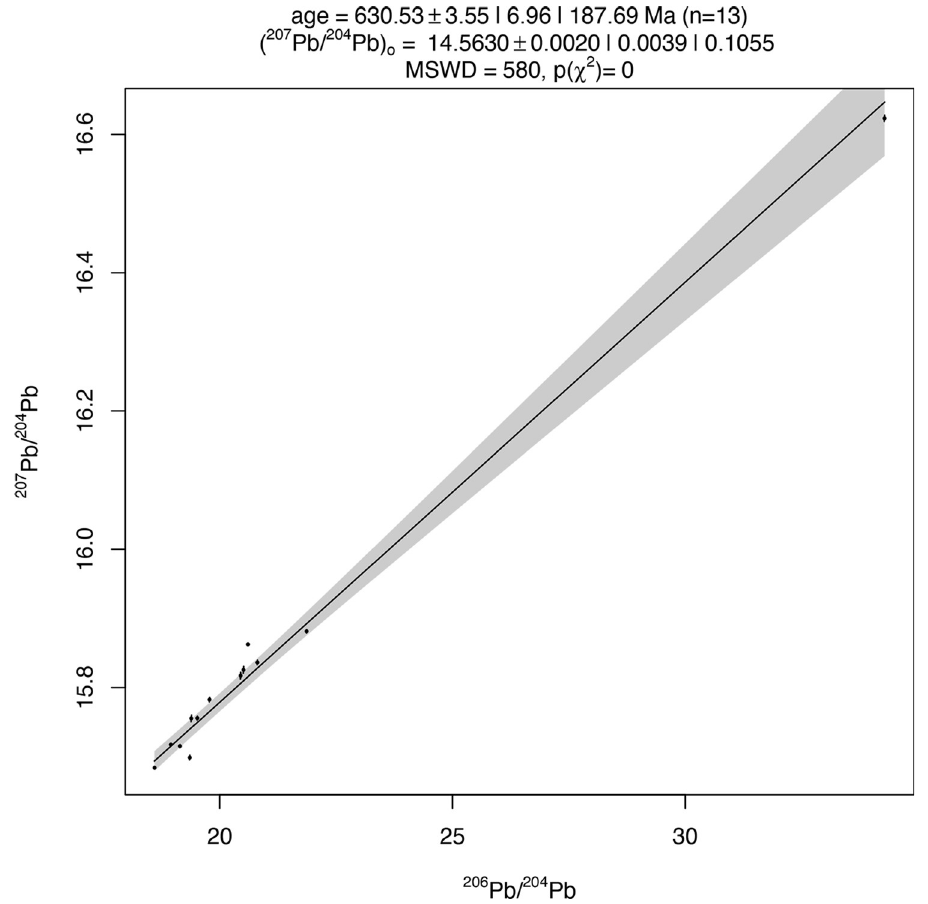
Fig 7. HIH and HXR ingot isochron. Produced from ingots with radiogenic lead isotopic data ( 206 Pb/ 204 Pb > 18.700. 207 Pb/ 204 Pb > 15.628). The Kent Estates ingot and ingots matching the Kipushi deposit were excluded from this calculation. 0.0039 is the 100(1- α )% confidence interval for the 207 Pb/ 204 Pb intercept. 0.1055 is the studentised 100(1- α )% confidence interval for u with overdispersion. The gray band around the regression line represents the confidence interval. MSWD is the Mean Square of the Weighted Deviates, and gives an indication of the mean distance of points from the line. Isochron calculated using the IsoplotR “three Ratio” option for Pb-Pb isochrons [71].